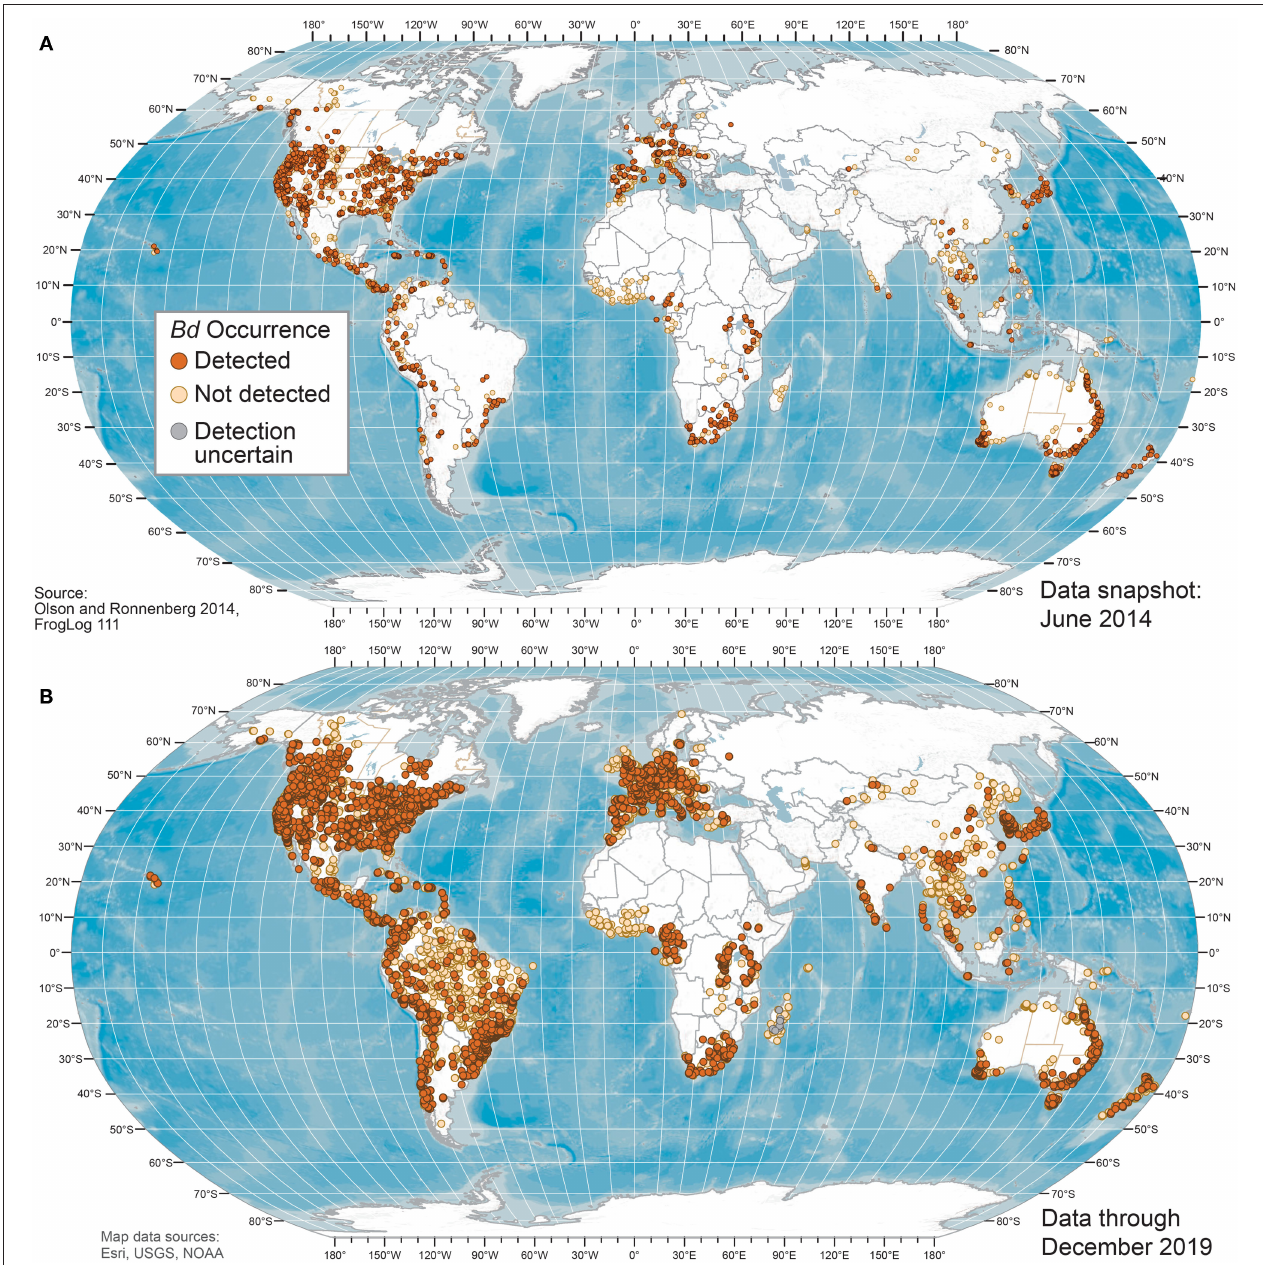
FIGURE 1 | World maps of Batrachochytrium dendrobatidis ( Bd ) occurrences at unique sites from data compiled for the Global Bd Mapping project through: (A) June 2014 (42); and (B) December 2019. Sites shown with Bd detections also may have sampling results with no detection; records with only country-level coordinates are not